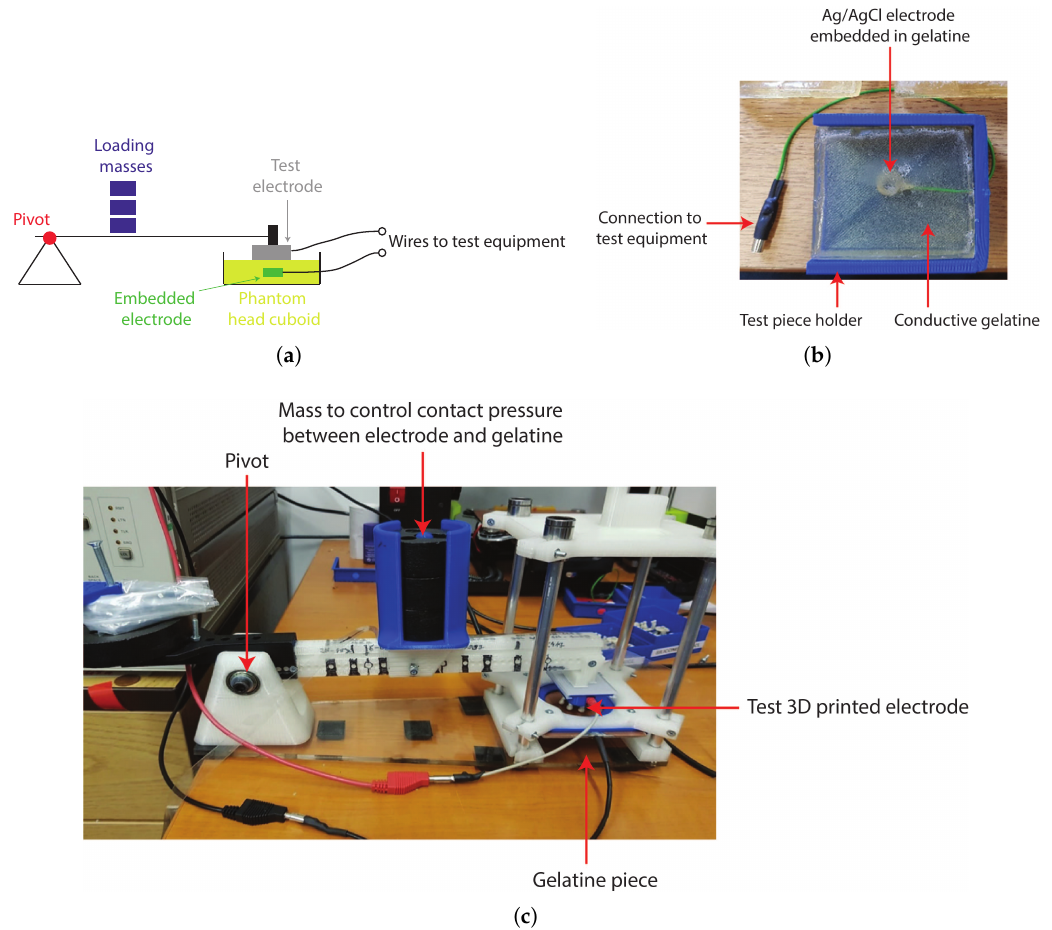
Figure 6. Test setup used. ( a ) Pivot structure used to control the force/pressure of the contact between the electrode and the gelatine test piece. ( b ) Conductive gelatine used as a phantom head, here set in the shape of a cuboid with an embedded reference electrode. ( c ) Photograph of the